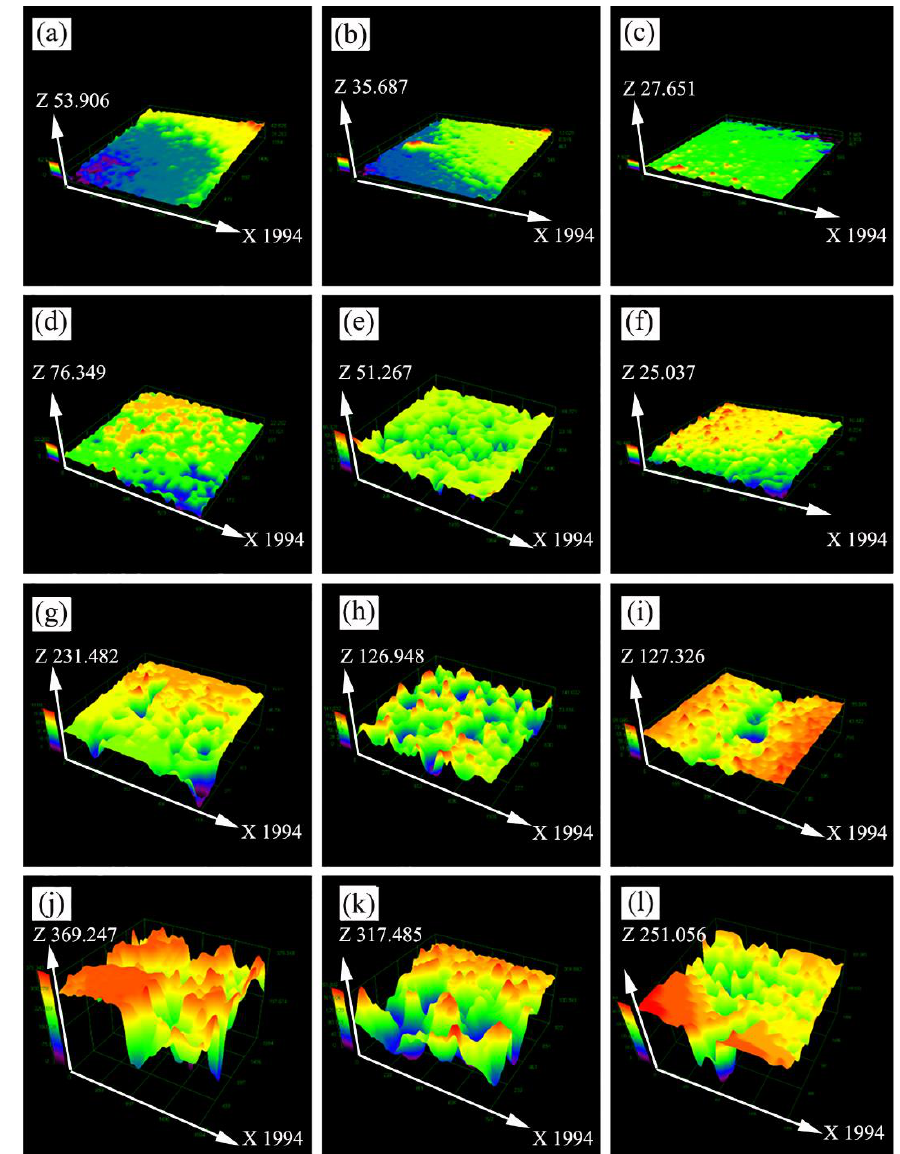
Figure 7. Three-dimensional surface morphology of Al, Al–5Ti, and Al–10Ti samples after cavitation erosion for different times: ( a – c ) 10 min; ( d – f ) 30 min; ( g – i ) 120 min; and ( j – l ) 300 min.